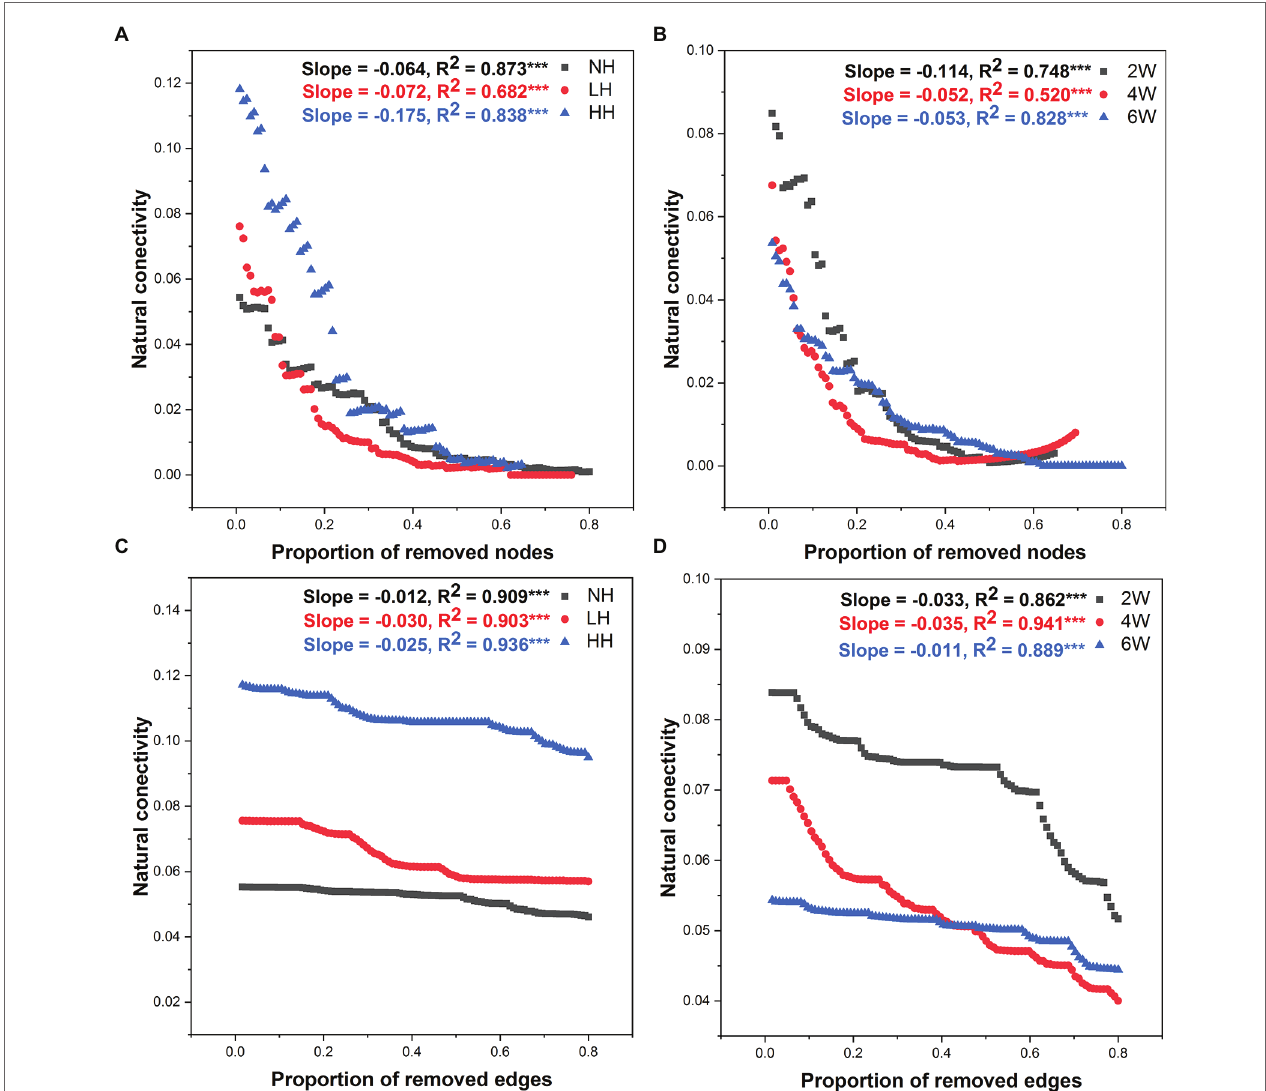
FIGURE 6 | Robustness analysis for the rhizosphere soil fungal community as affected by different lengths of elapsed time since herbivore removal (A,C) and differing intensities of herbivory (B,D) . Robustness analysis is depicted as the relationships between microbial natural connectivity and the proportion of excluded nodes and edges, such that larger shifts for the same proportion indicate less robustness or stability within the fungal networks. *** p <